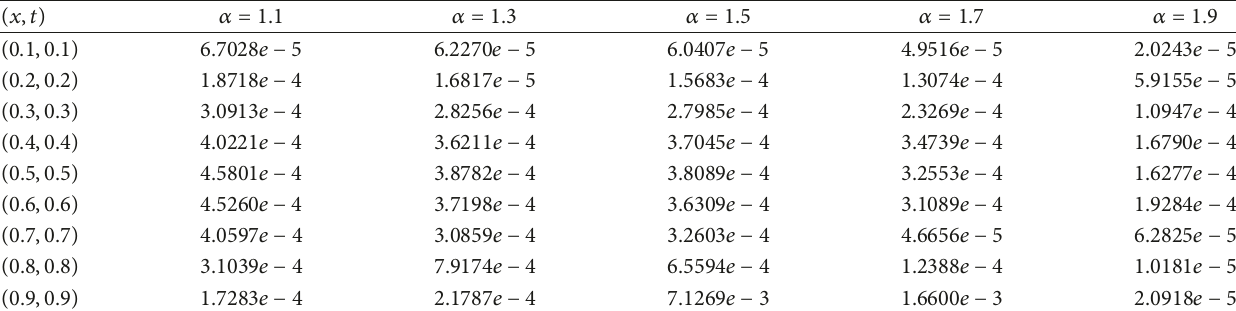
Table 4: The absolute errors for Example 2 for some different values 1 < 𝛼 ≤ 2 at some different points in [17].